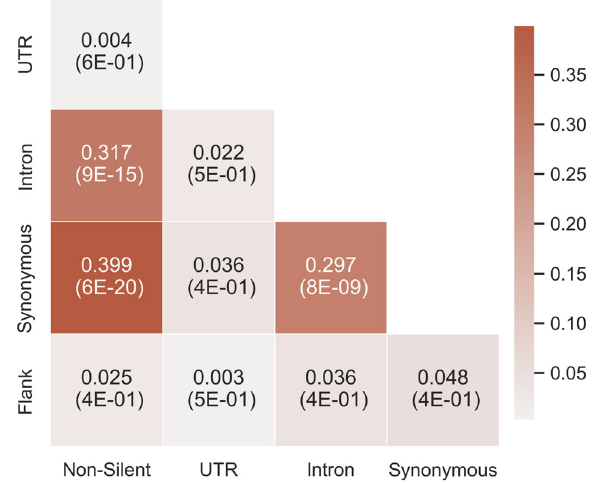
Fig. 6 The average Spearman correlation of every pair of gene ranking lists of two models. For every cancer type, the correlation between the gene ranking lists of every pair of models was calculated. The average value across cancer types is shown. The respective average p-values are denoted in parentheses. The colors represent the correlation coef fi cient. A darker color indicates a higher